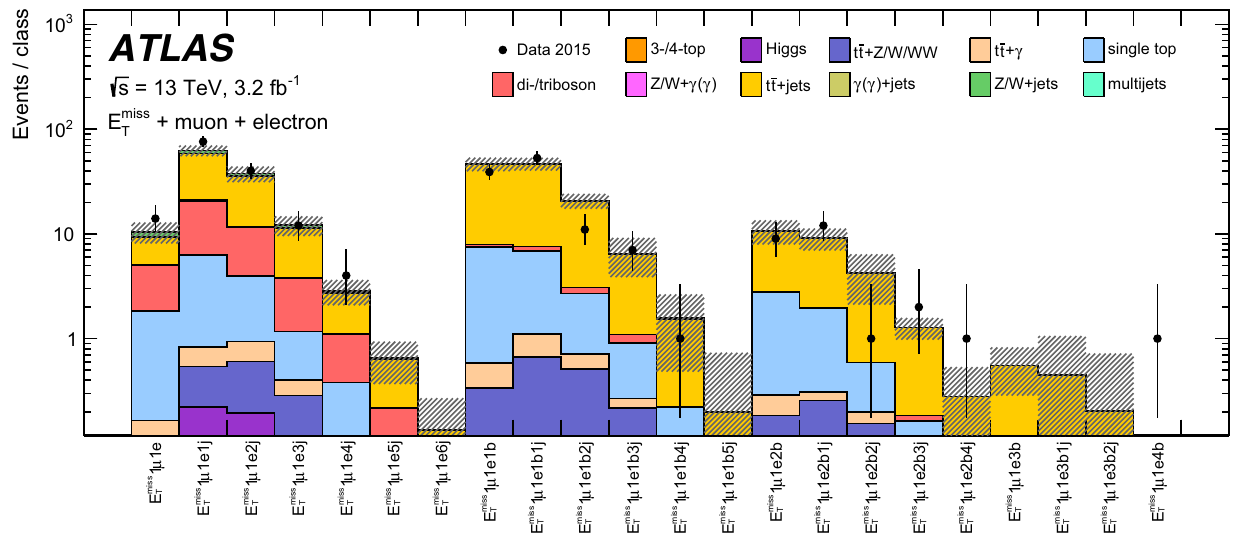
Fig. 21 The number of events in data, and for the different SM back- ground predictions considered, for classes with large E miss one electron and ( b -)jets (no photons). The classes are labelled accord-